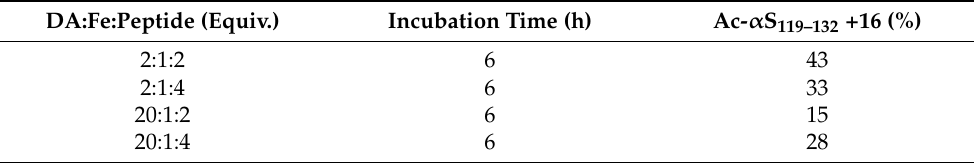
Table 1. Effect of Ac- α S 119–132 concentration on the extent of peptide oxidation.